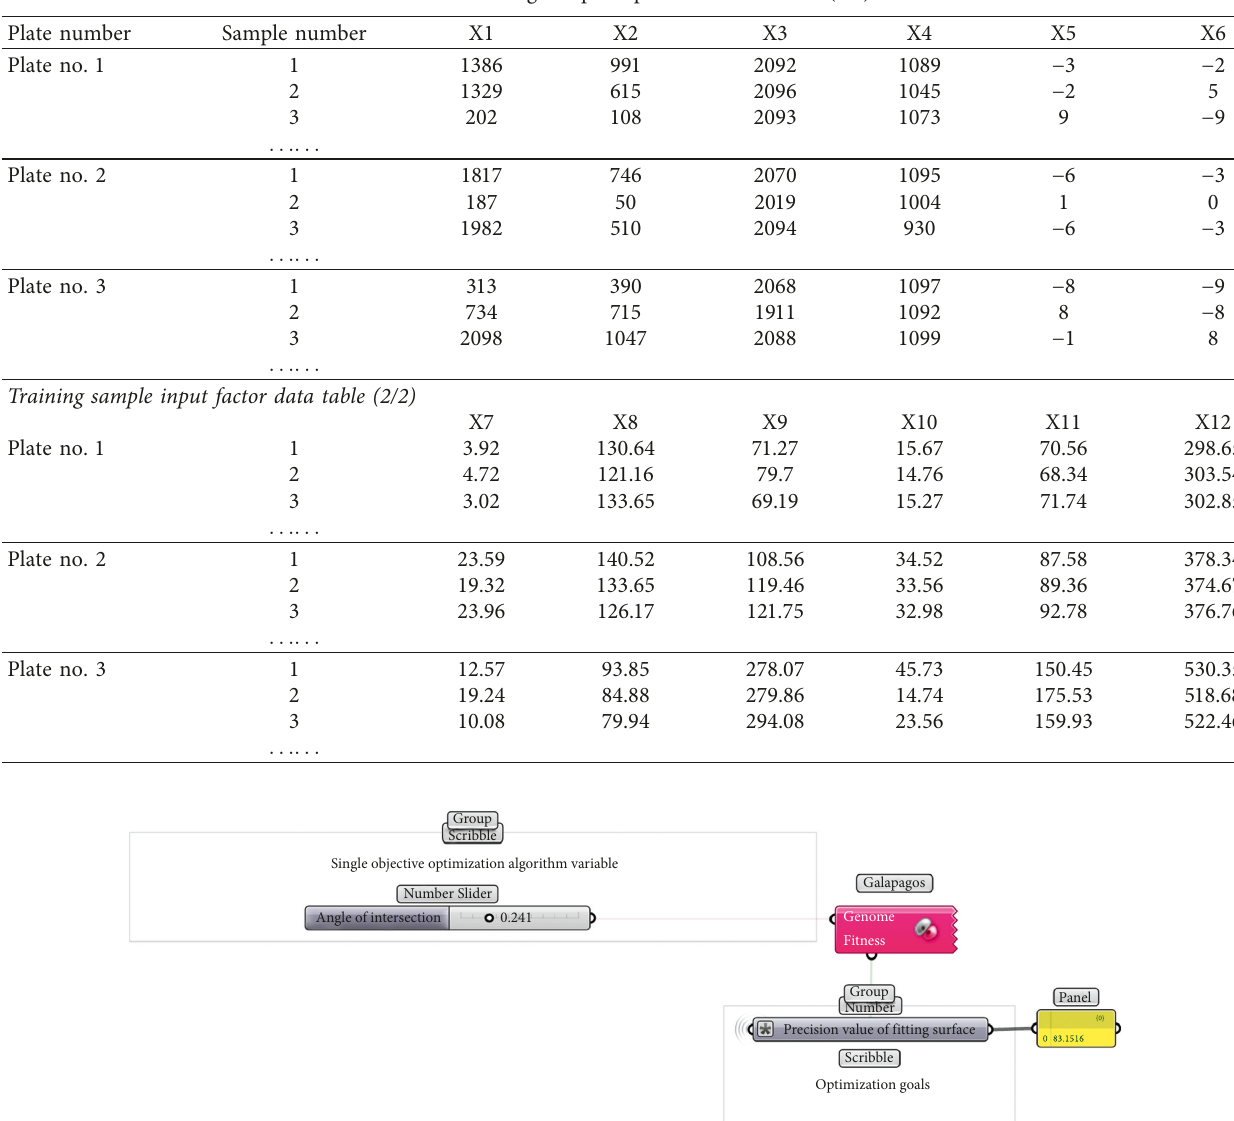
Table 2: Training sample input factor data table (1/2).